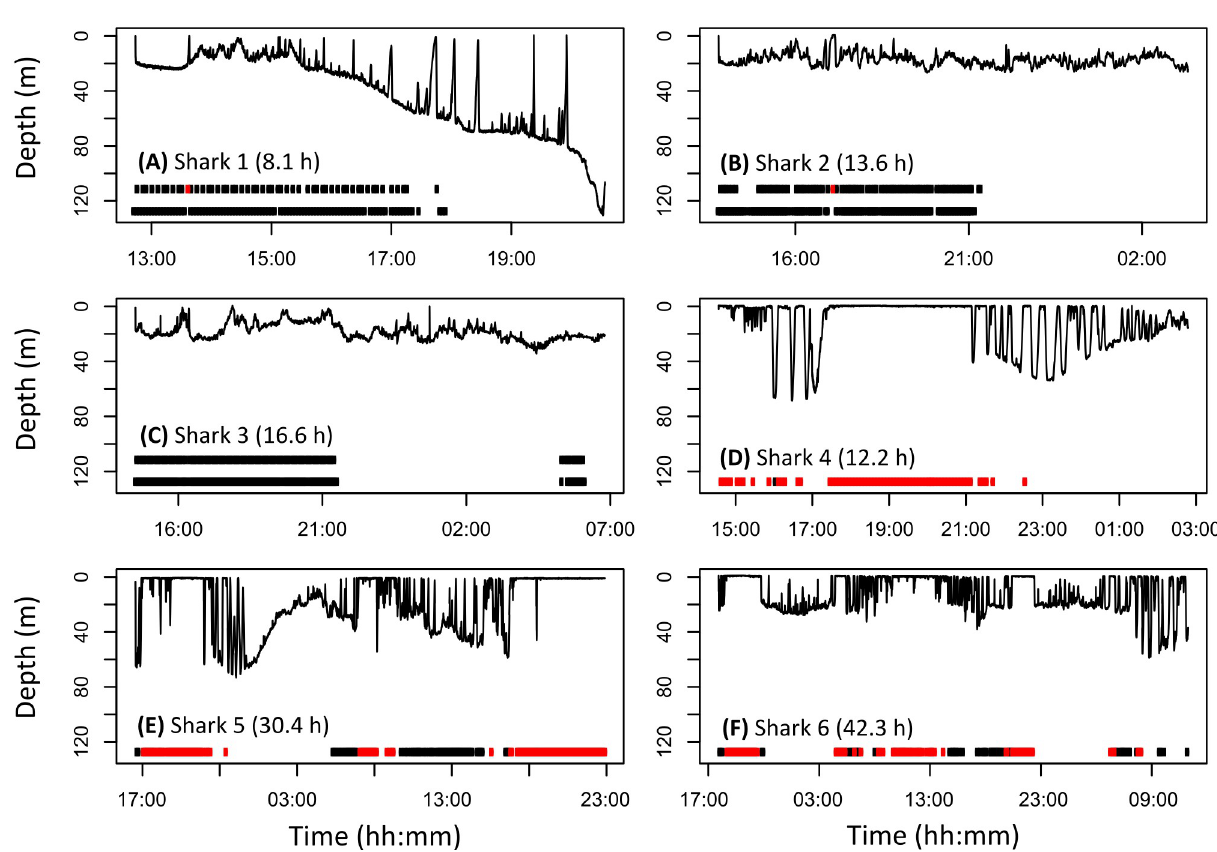
Fig 3. Depth use behaviour of basking sharks gathered from towed camera tags. (A) Shark 1, (B) shark 2, and (C) shark 3 tagged in 2018, and (D) shark 4, (E) shark 5 and (F) shark 6 tagged in 2019. Periods of seabed (black bars) or surface swimming (red bars) when ambient light permitted habitat characterisation, where the top bars in A-C represent depth use inferred from duty-cycled video data, and lower bars continuous data. Tracking duration (h) shown in parentheses.